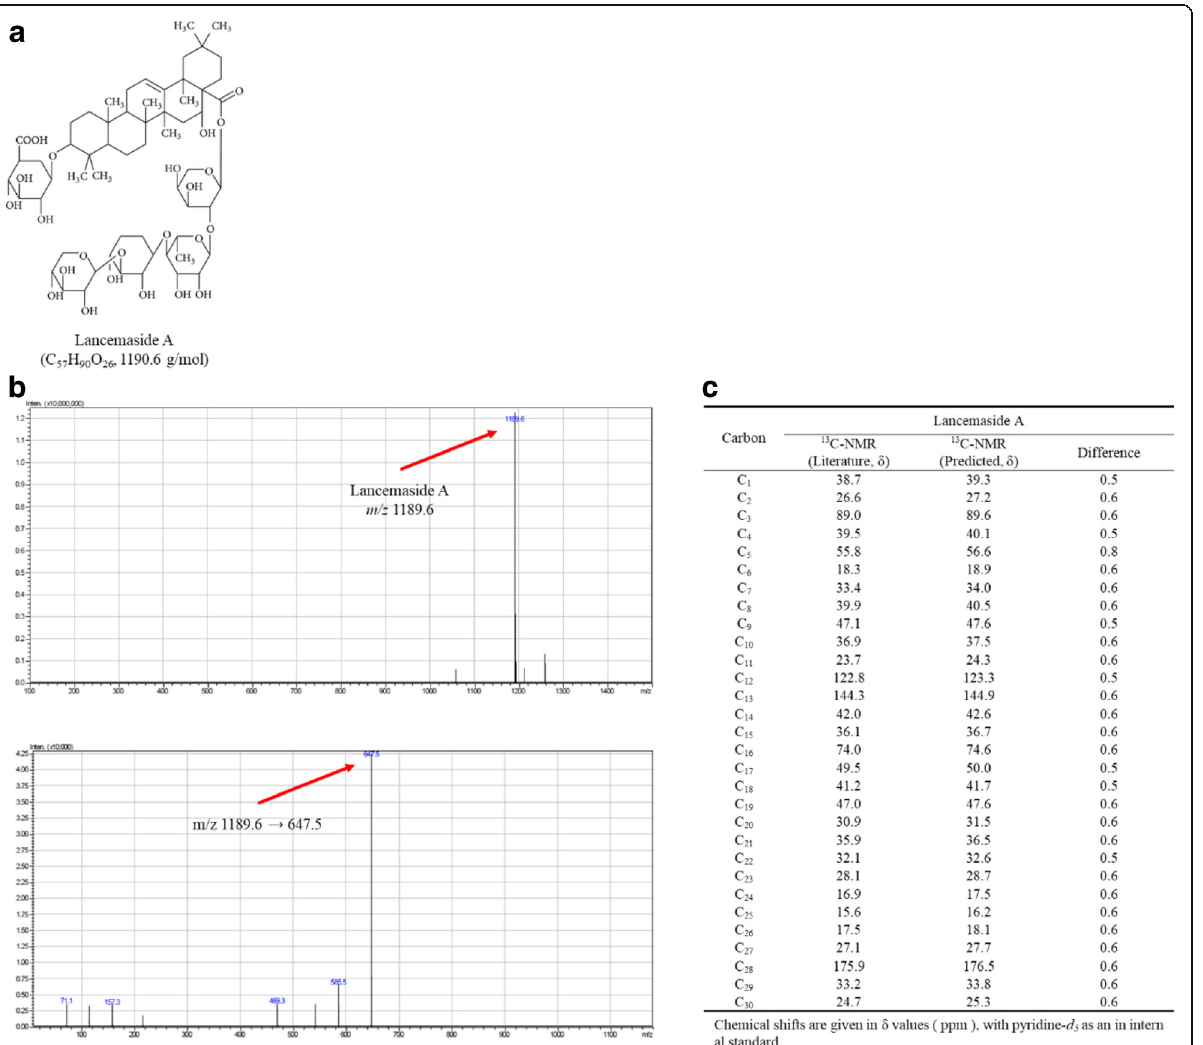
Fig. 1 Identification of LA from C. lanceolata . a Structure of LA ( b ) Mass spectra of precursor ion of LA and their fragmentation product ion were obtained in ESI negative-ion detection mode ([M-H] − ). In the mass spectrum, LA showed the ions to be at m/z 1189.6 (top panel). The tandem mass spectrum of the relative fragmentation product ions was monitored at m/z 1189.6 → 647.5 for LA (bottom panel). The product ion at m/z 647.5 was produced by loss of a tetrasaccharide unit (arabinose, rhamnose, and two xyloses). c For analysis of the correlation of the 13 C-NMR values ( δ , ppm) of LA, the 13 C-NMR data of LA were obtained from the literature. To validate the 13 C-NMR data of LA, the chemical shifts of LA were observed and compared with the literature